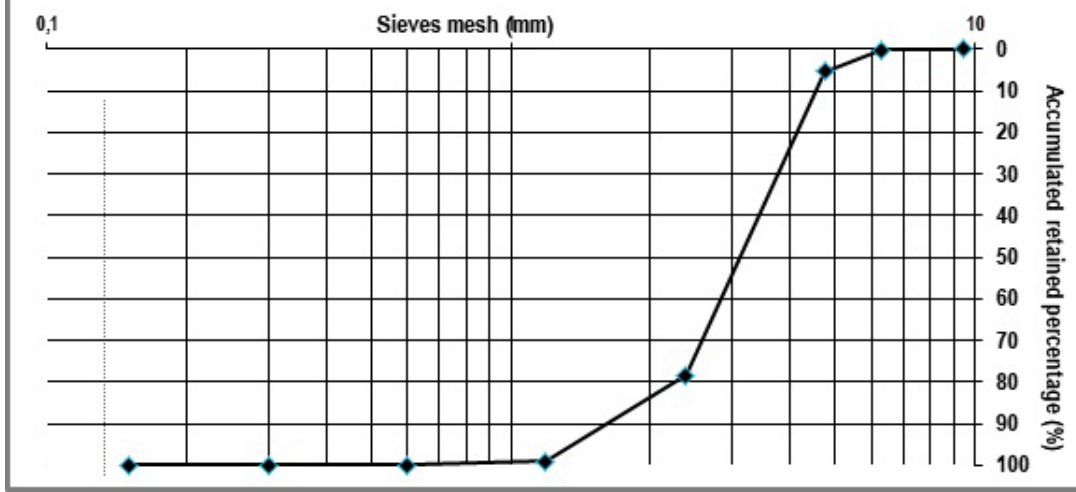
Figure 5. Result of eucalyptus particle size test.